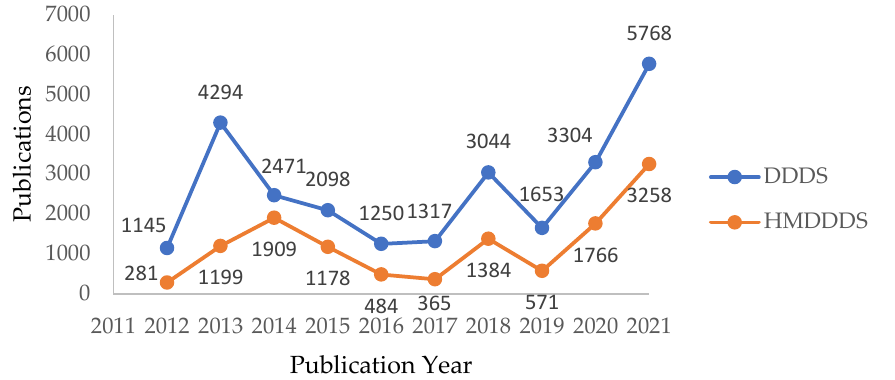
Figure 5. Publication trends based on DDDS and hybrid-based DDDS from 2012 to 2021.